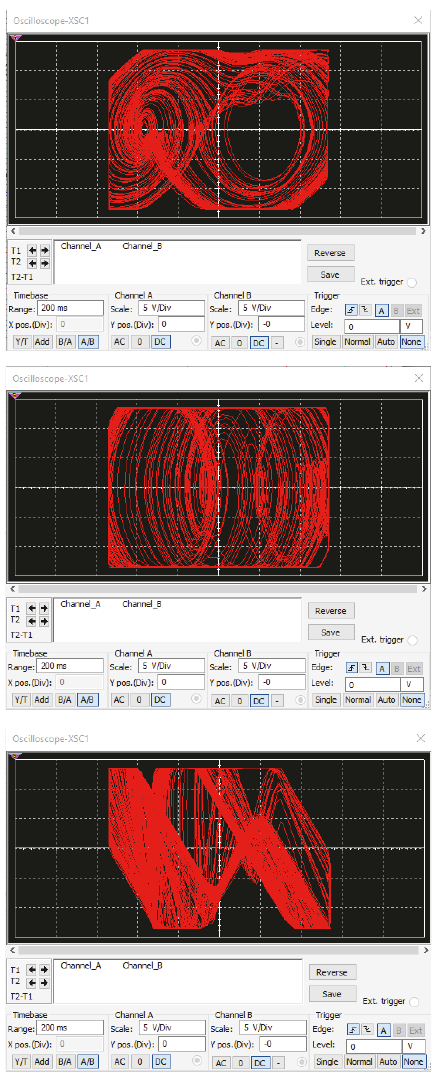
Figure 10: Simulation results of the hyperchaotic system with MultiSIM